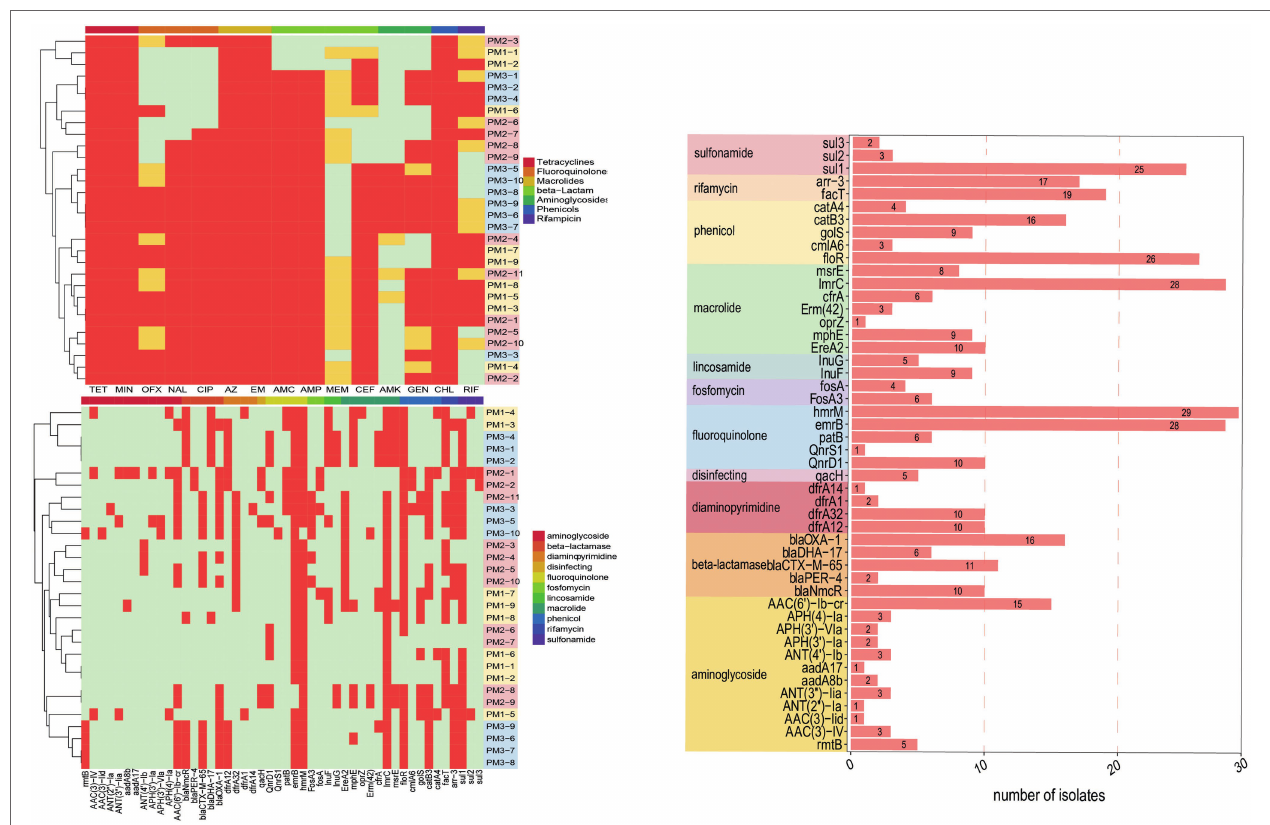
FIGURE 5 | ARGs present in P. mirabilis genomes of study isolates. (A) Phenotype; PM 1–5, PM 2–12 were resistant to all the tested drugs. (B) Genotype, excepting ARGs that all strains contained. (C) Fluoroquinolone, macrolide, phenicol, and sulfonamide prevalence. Red, positive; green,